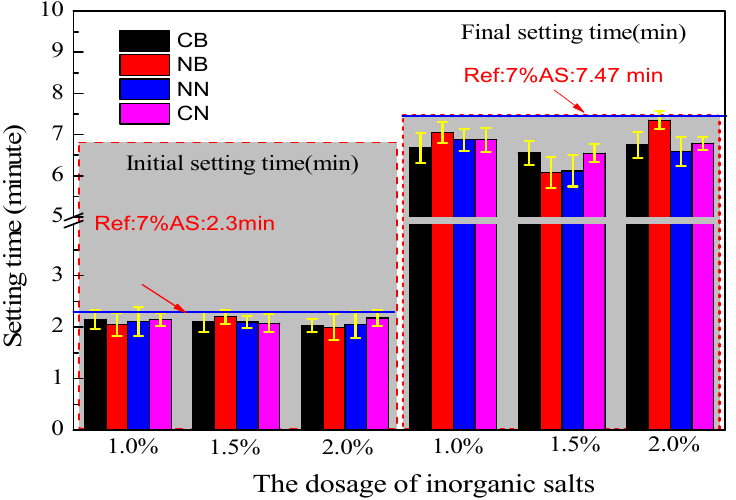
Figure 2. Effects of inorganic salts on setting time at low temperature.